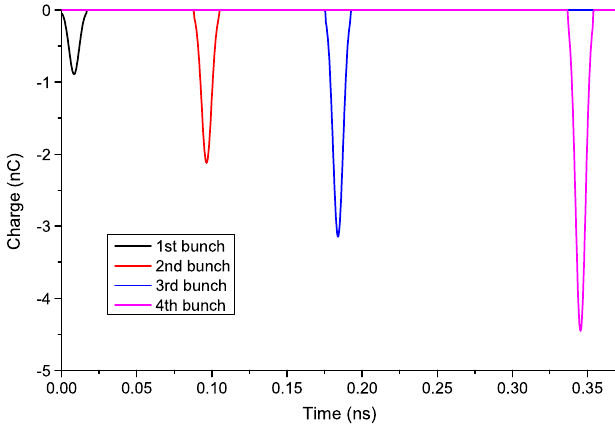
FIG. 7. Spacing and charge, emitted per one computation time step ( (cid:1) t ¼ 4 : 4 (cid:5) 10 (cid:2) 4 ns ), of the four drive bunches used for the computation of wakefields shown in Fig. 6.